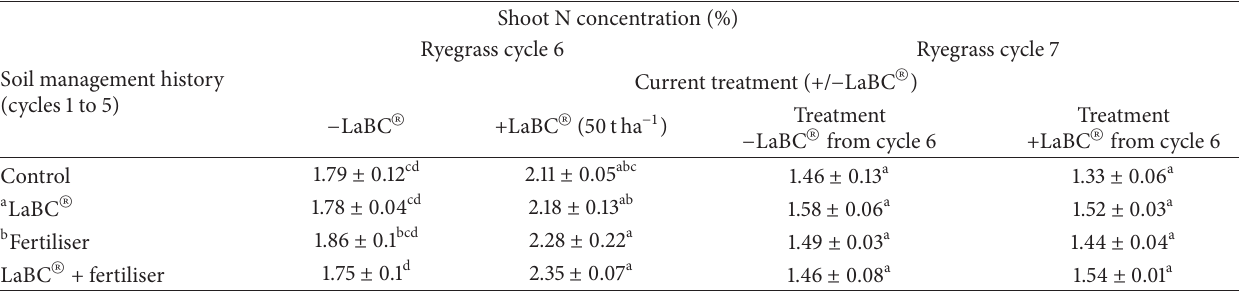
Table6:ShootNconcentration(%)inryegrasscycles6and7withreappliedLaBC Ⓡ (+/ − )asinfluencedbyresidualeffectsofsoilamendments from previous management